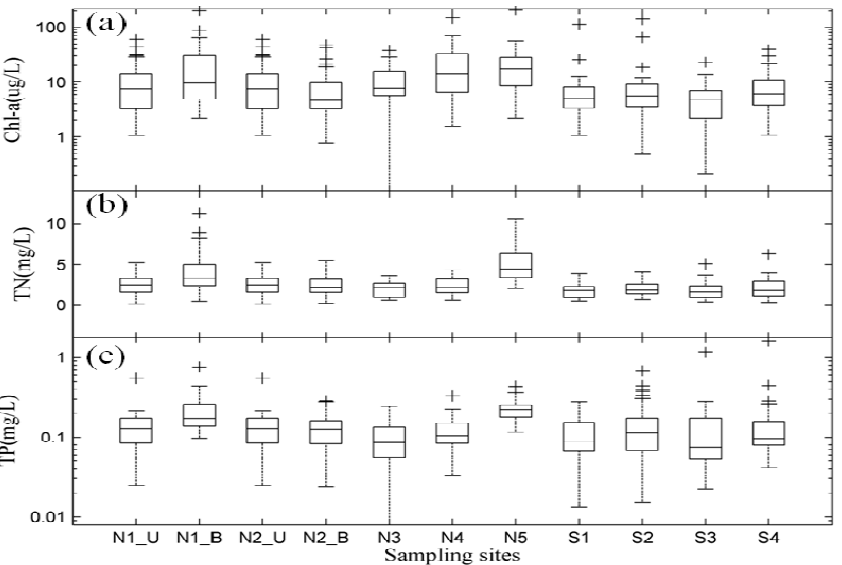
Figure 6. Spatial distribution of TN, TP and Chl-a in Lake Taihu based on monthly data. ( a ) Chl-a; ( b ) TN; and ( c ) TP. N1_U: surface of station N1; N1_B: bottom of station N1; N2_U: surface of station N2; N2_B: bottom of station N2. boxplot based on nine sampling sites. The cross “+” represents